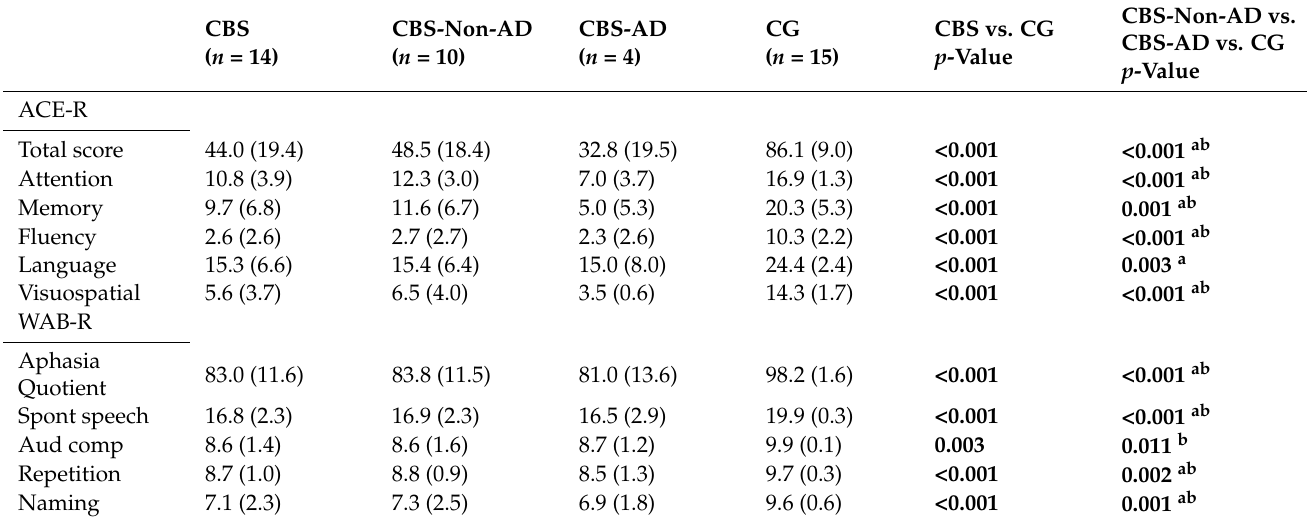
Table 3. Performance on cognitive and language tests across diagnostic groups.